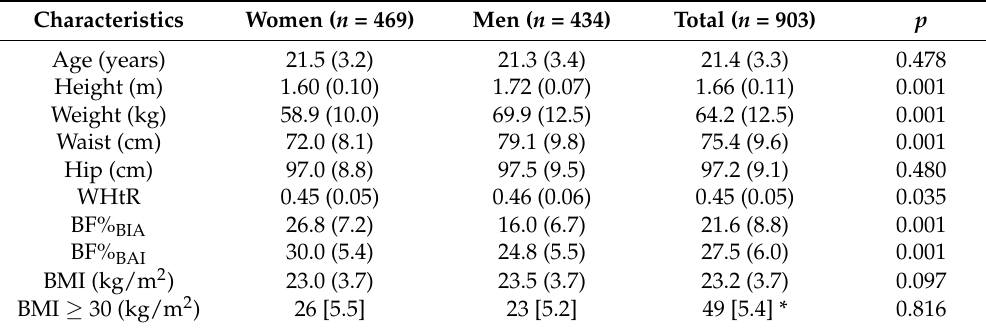
Table 1. Characteristics of study subjects as a whole and by